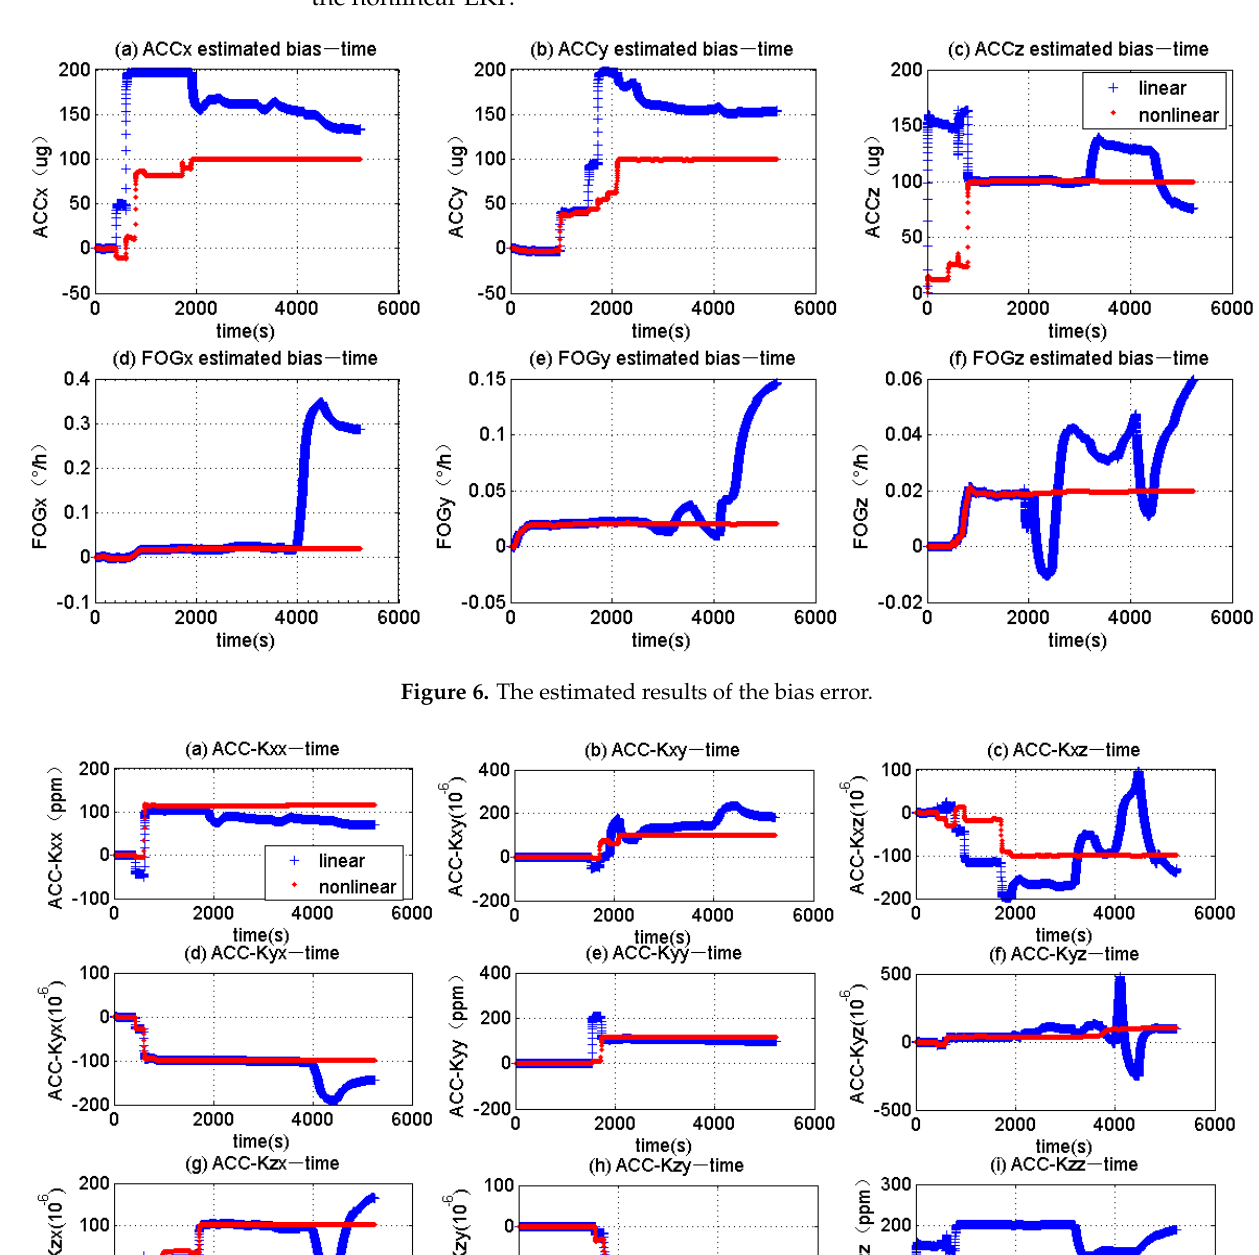
estimated by the linear EKF, while the red line represents the error coefficient estimated by the nonlinear EKF.